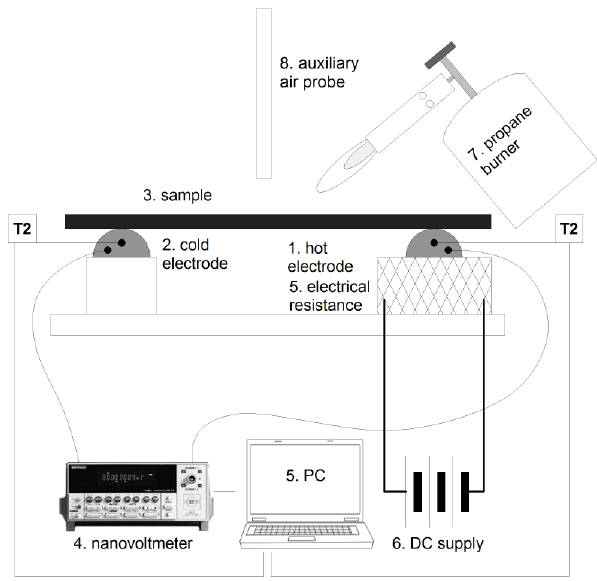
Figure 1. Experimental setup for thermoelectric